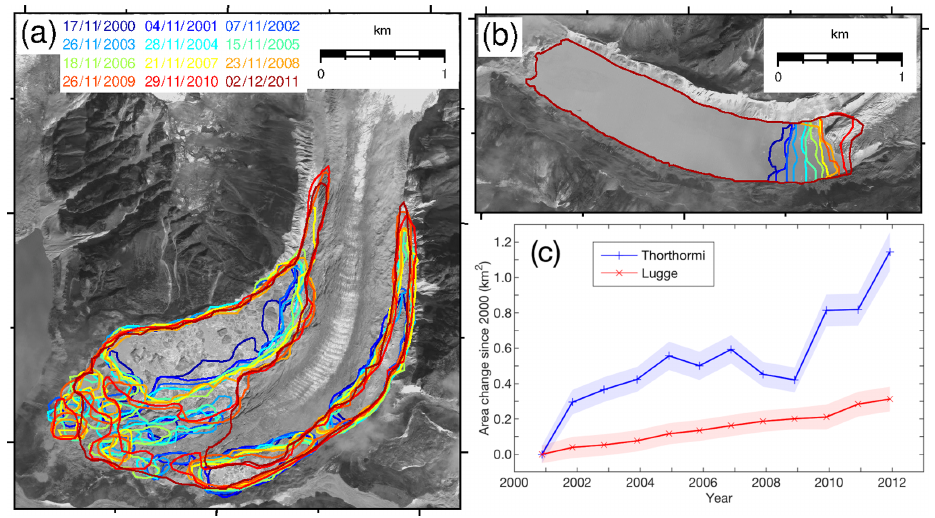
Figure 4. Glacial lake boundaries in (a) Thorthormi and (b) Lugge glaciers from 2000 to 2011 and (c) cumulative lake area changes of the glaciers since 17 November 2000. The background image is an ALOS PRISM image acquired on 2 December